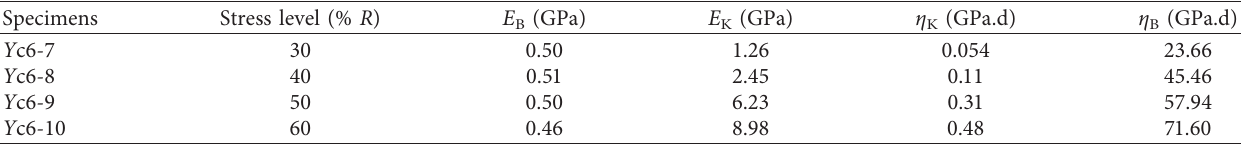
Table 7: Recommended creep parameters of the filling